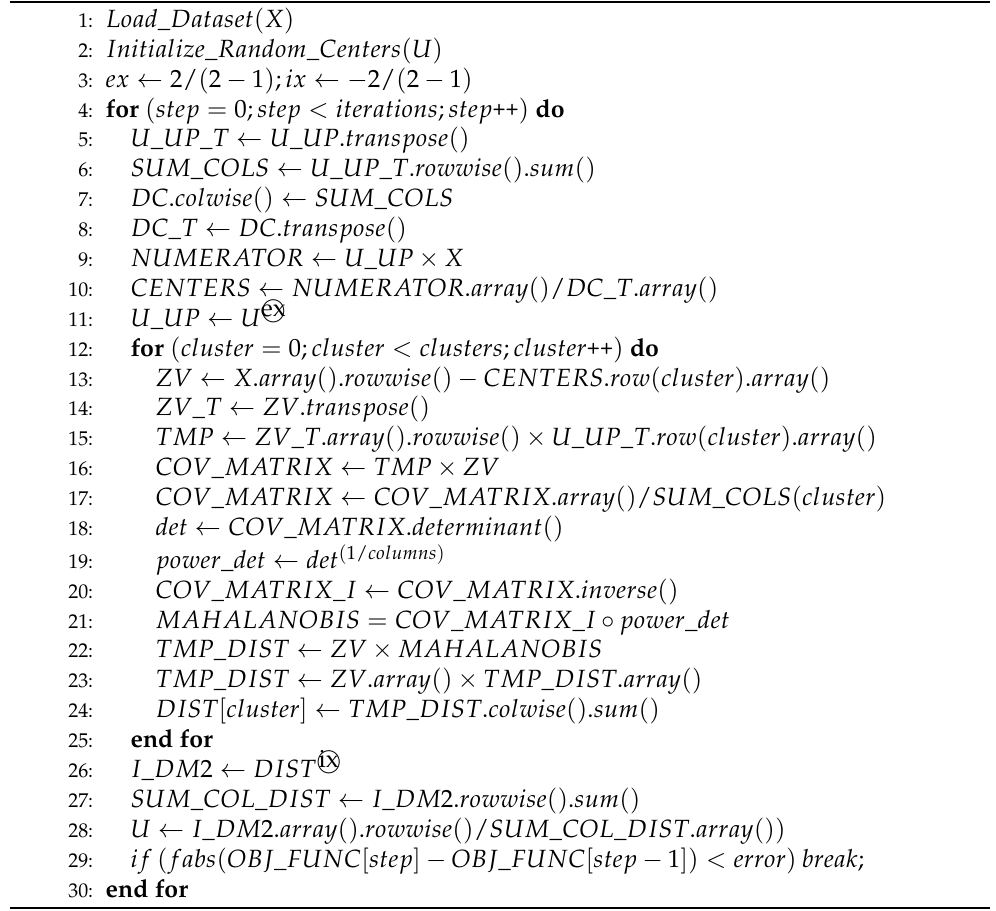
Algorithm 7: Eigen pseudocode for the main loop of the GK-FCM